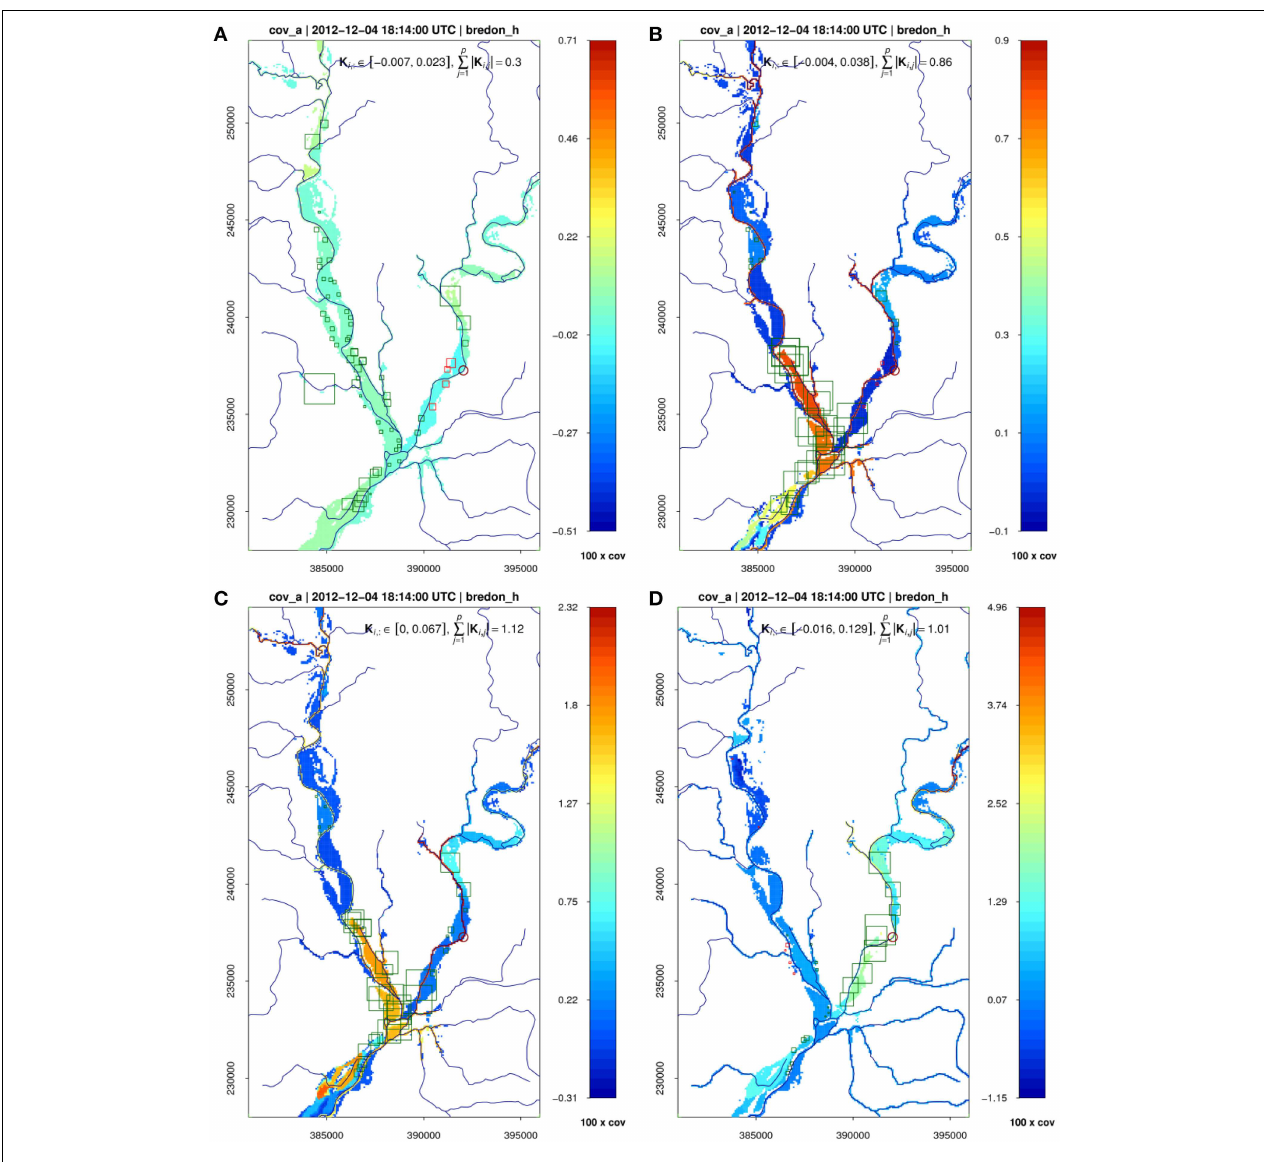
FIGURE 4 | Updated error covariance between the state variable (water level) at Bredon and the state vector (water level elsewhere) at the last assimilation step (7th CSK overpass), for (A) global filter, (B) local filter with Euclidean distance localization, (C) local filter with along-network distance localization, and (D) as (C) but with parameter estimation. Color scales are independent for each plot to ease visualization. The red